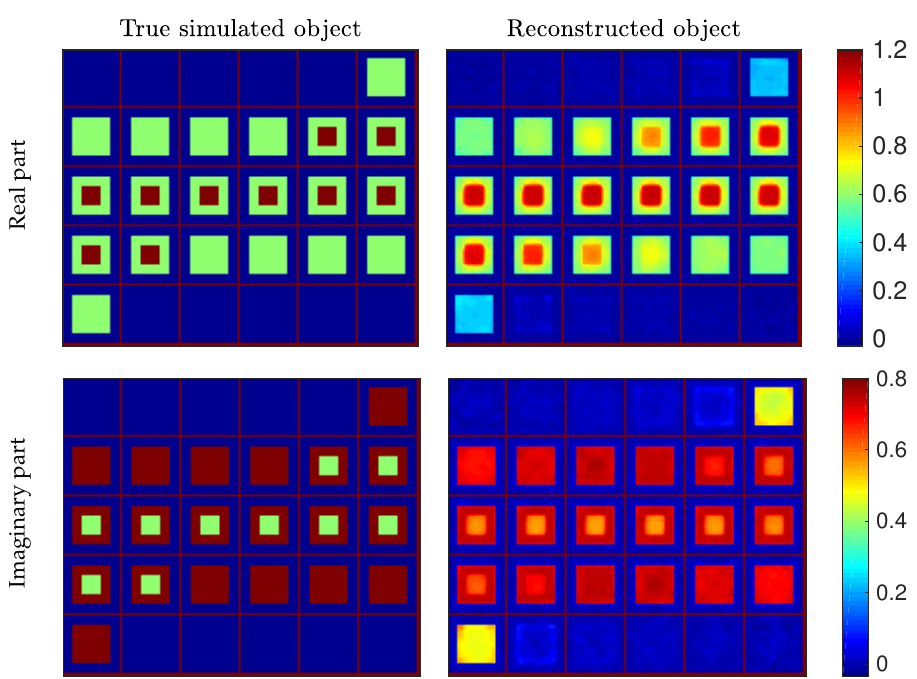
Figure 3. Reconstruction results (contrast values) for the simulated object defined in Section 4.1. Each panel represents the 30 slices (30 × 30 pixel images) of the three-dimensional object. True ( left ) and reconstructed ( right ) objects, with real ( top ) and imaginary ( bottom ) parts of the contrast